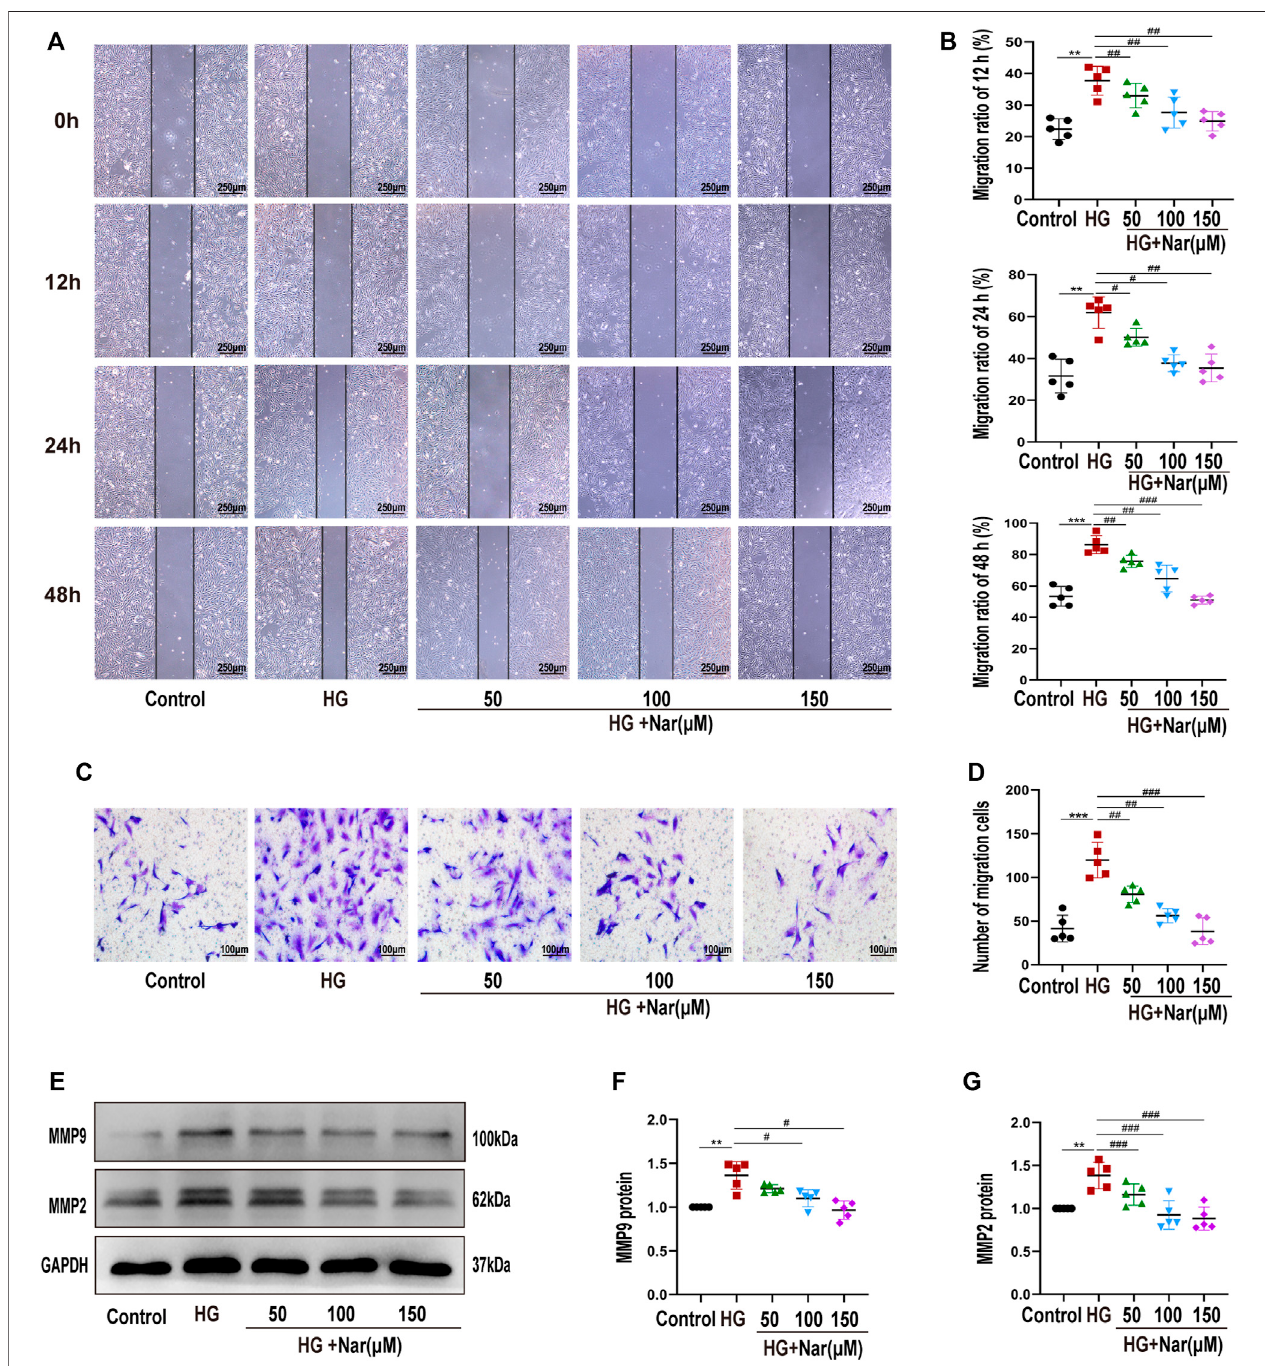
FIGURE 4 | Nar inhibited high-glucose-induced VSMC migration. (A,B) Wound healing assay of VSMC migration at 12, 24, and 48 h (magni fi cation: 40×). (C,D) Transwell migration assay of Control group, HG group, and groups with diverse doses of Nar (magni fi cation: 200×). (E – G) Western blot analysis of MMP2 and MMP9 expression. ** p < 0.01 compared with Control group, ## p < 0.01 compared with HG group.